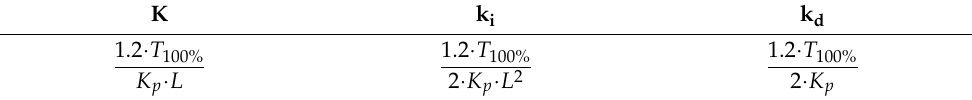
Table 2. Summary of values for k, k i , and k d according to the approximated M -constrained integral gain optimization (AMIGO) method. k k i k d